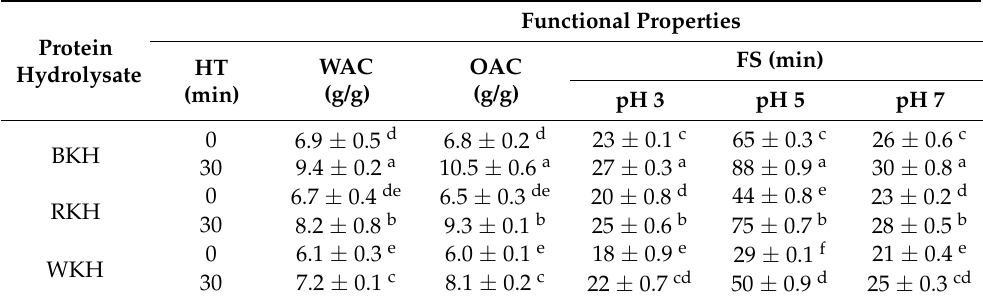
Table 2. Functional properties of black, red and white kidney bean protein hydrolysate (BKH, RKH, and WKH) obtained after 30 min Alcalase hydrolysis at 37 ◦ C.